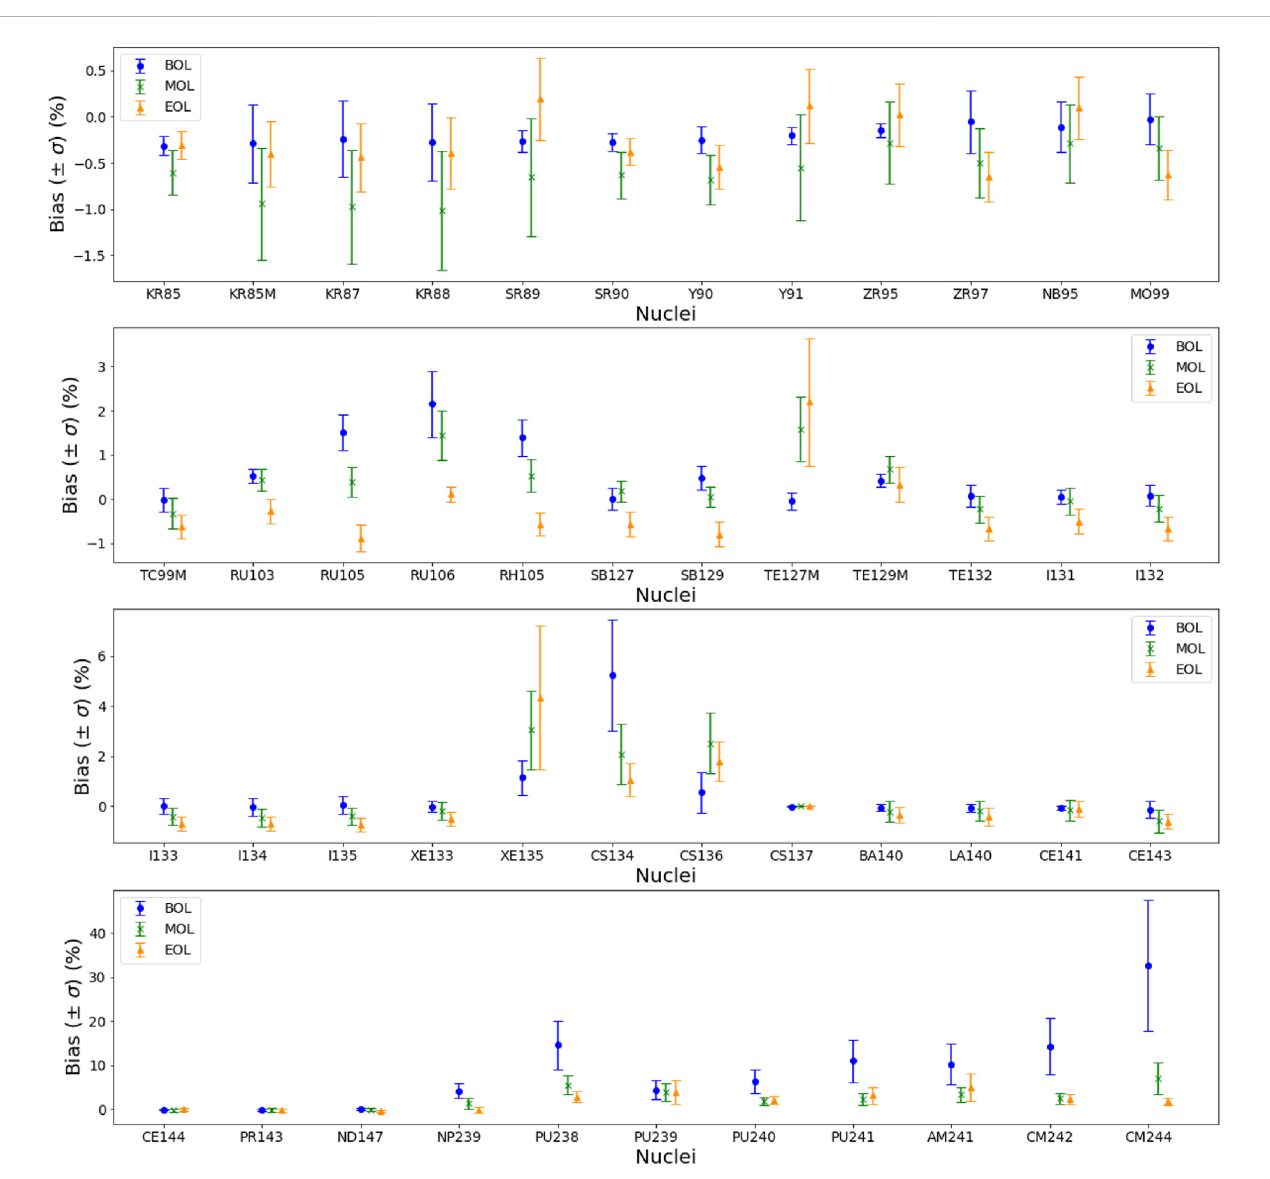
Average bias and its uncertainty (1 σ ) due to ILA on the assembly nuclide inventory, for three burnup values, for UO 2